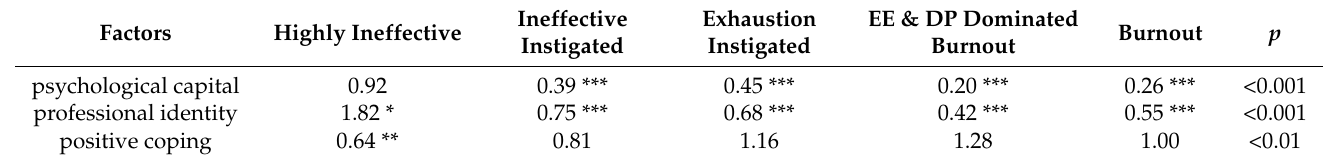
Table 5. The OR of the probability of each profile at T1 under the effects of resource